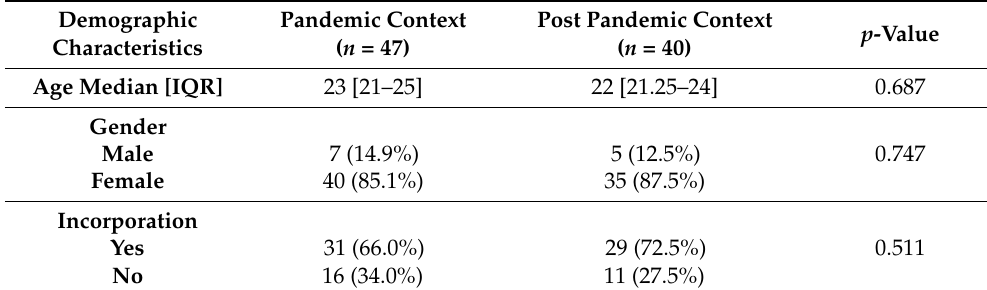
Table 1. Demographic characteristics and incorporation or not into health system due to the context of the pandemic in